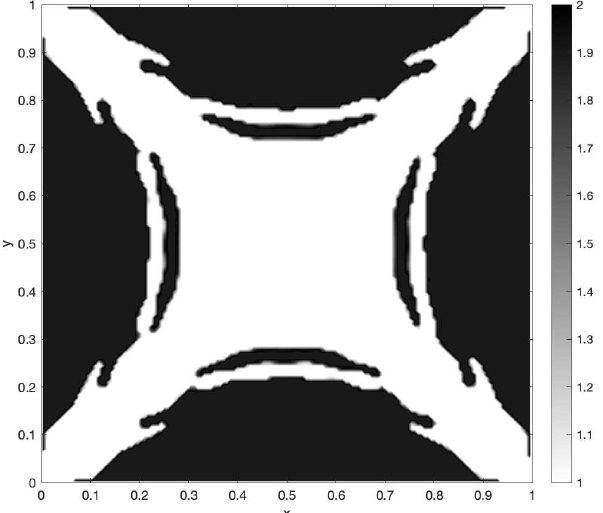
Figure 4: Approximated Optimal Control